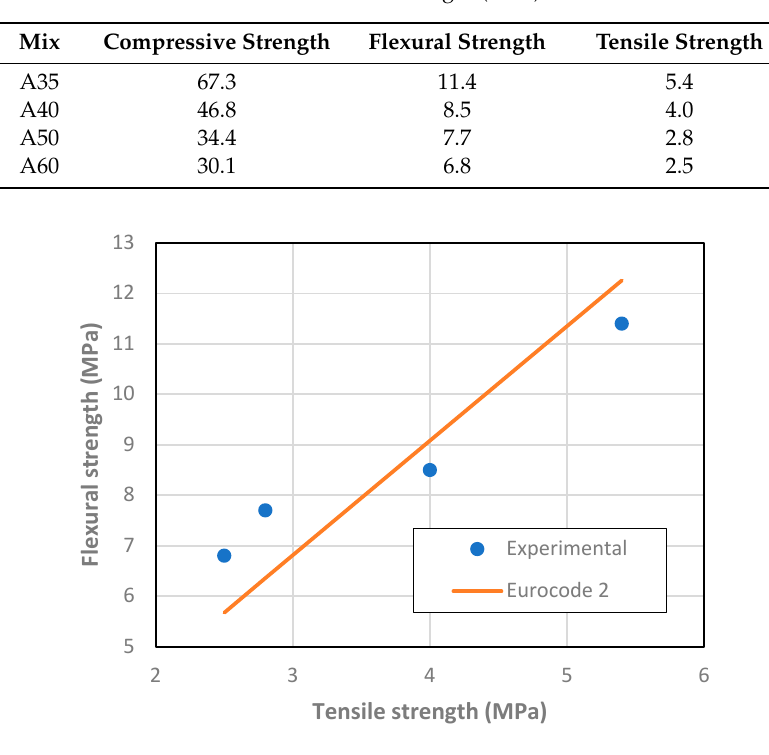
Figure 6. Relationship between matrix tensile and flexural strength.